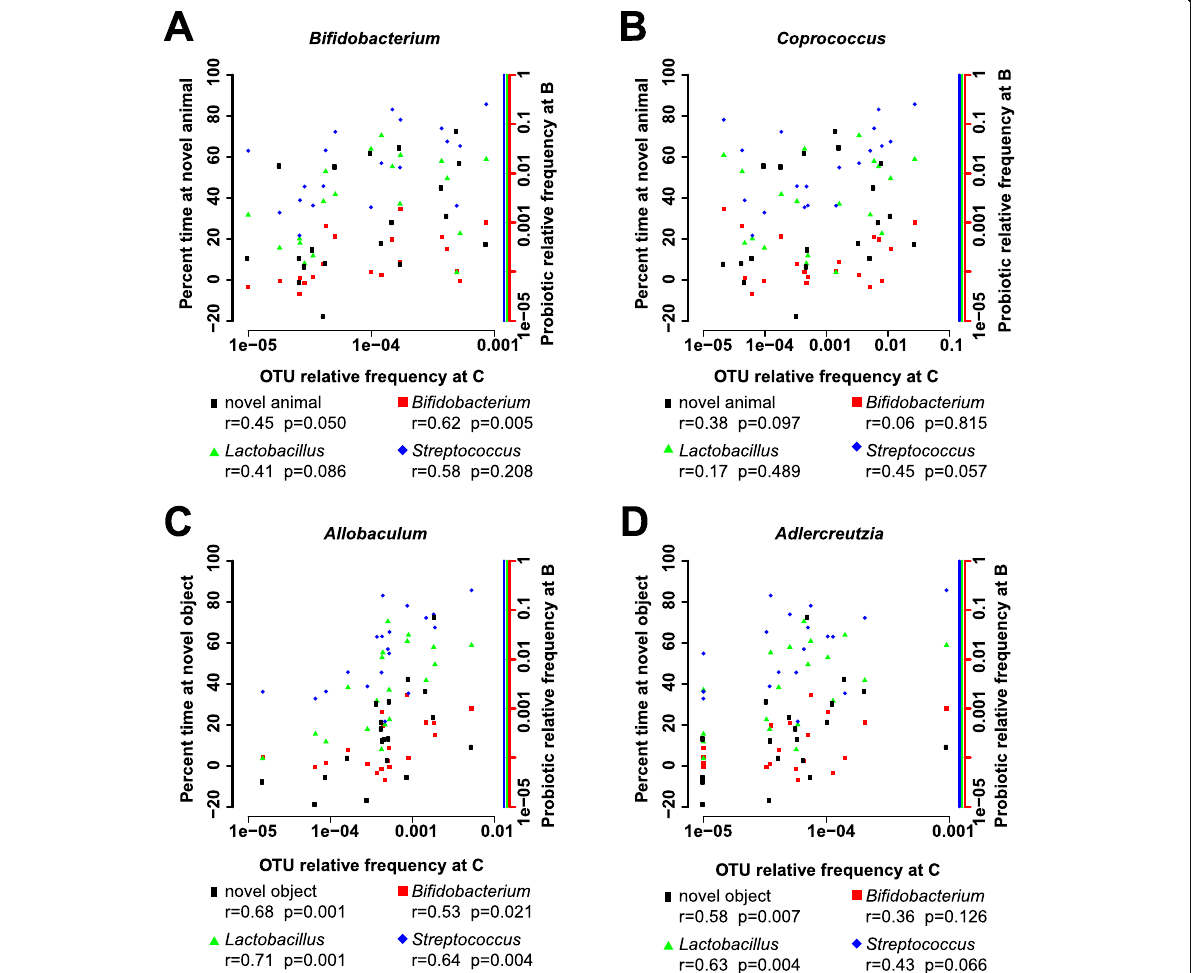
Fig. 3 Correlation of OTUs with novel animal or novel object behavior and with probiotic organism relative frequency. Plots are shown for the OTUs Bifidobacterium , Coprococcus , Allobaculum and Aldercreutzia in panels a, b, c and d , respectively. Relative OTU frequency at timepoint C is plotted on the x axis. Percent time at novel object or novel animal, minus percent time at familiar object or familiar animal, is plotted on the left y axis, and relative frequency of probiotic organisms at timepoint B is plotted on the right y axis. The left y axis and x axis are plotted in log10 scale. OTU relative frequency / novel object/animal pairs are plotted in black rectangles, while OTU relative frequency / probiotic organism relative frequency pairs are plotted in red squares, green triangles and blue diamonds (for Bifidobacterium , Lactobacillus , and Streptococcus , respectively). The Spearman rho (r) and nominal p-value for each correlation is indicated in the key for each